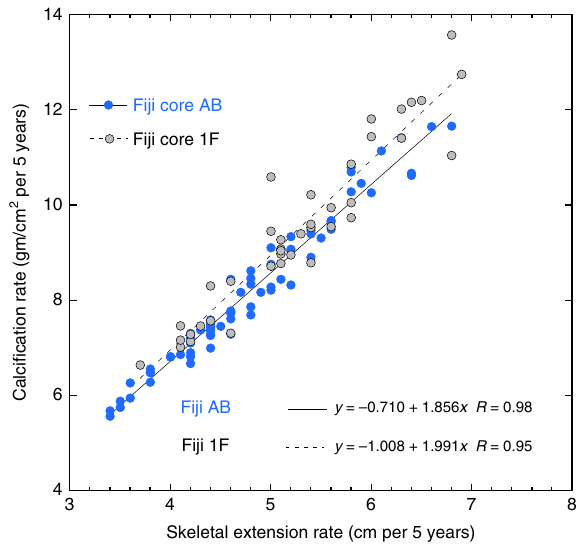
Fig. 4 Fiji Porites coral extension and calci fi cation rates: correlation of skeletal extension rate and calci fi cation rate in Fiji coral cores 1F and AB. Data calculated and presented as 5-year averages of extension and calci fi cation. Correlation coef fi cients ( R values) for core 1F = 0.95 and for core AB = 0.98. Source data are provided as a Source Data fi le in